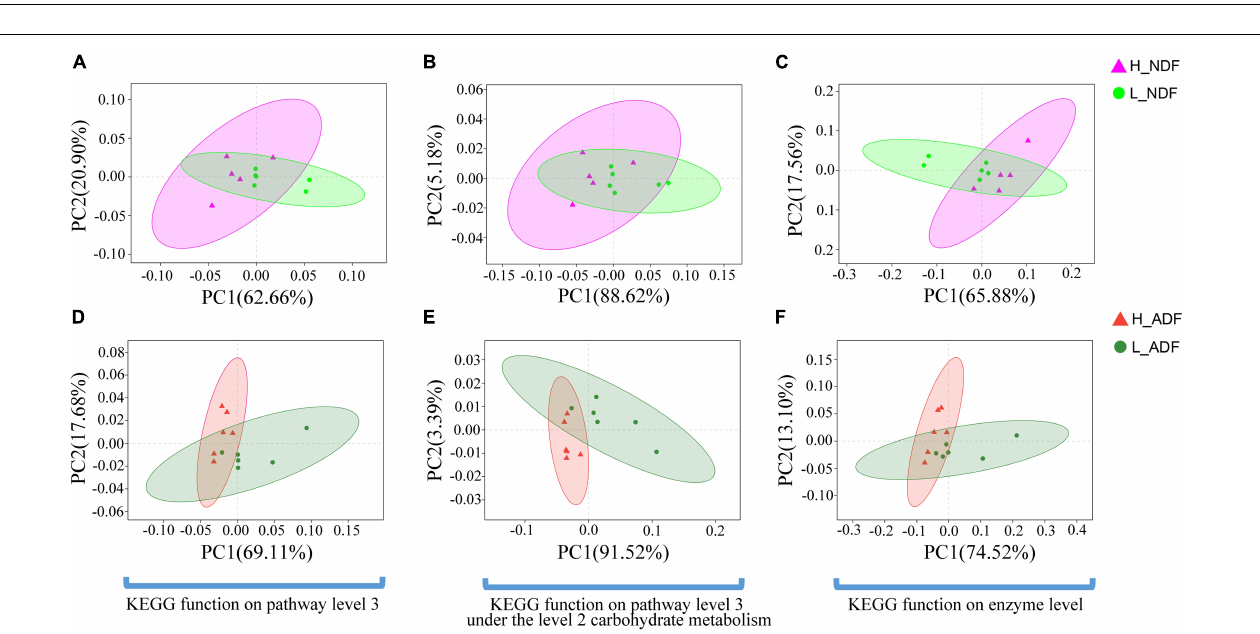
FIGURE 8 | Schematic overview of intestinal microbial metabolic pathways from degradation of complex polysaccharides to production of short chain fatty acids.